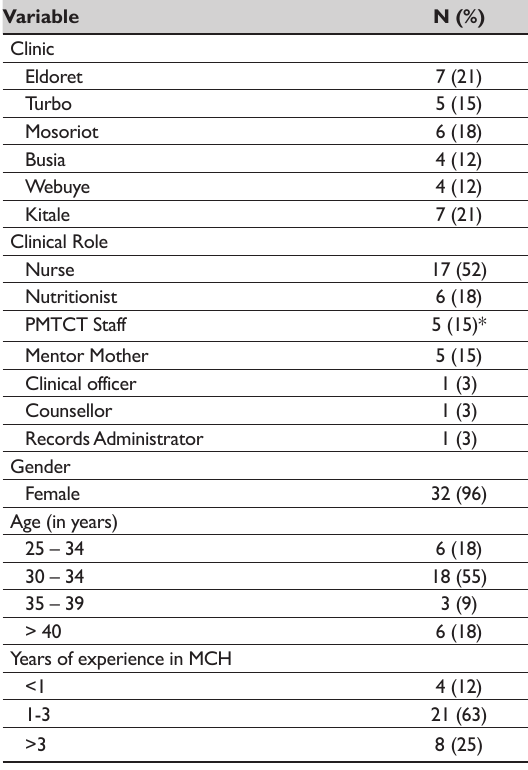
Table 2: Demographics of clinical staff